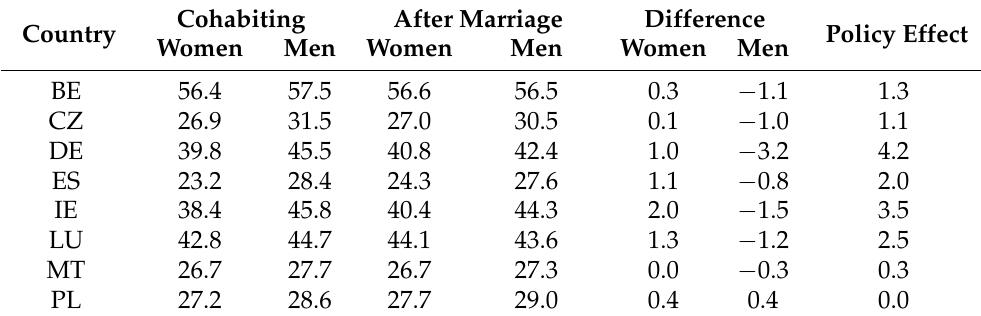
Table A2. The average METR before and after marriage for cohabiting couples, and policy effect on the gender gap in METR.